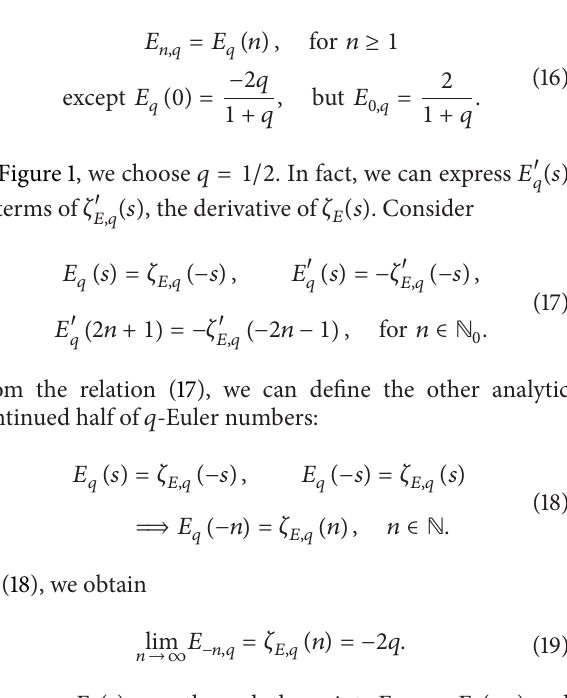
All the 𝑞 -Euler numbers 𝐸 𝑛,𝑞 agree with 𝐸 𝑞 (𝑛) , the analytic continuation of 𝑞 -Euler numbers evaluated at 𝑛 (see Figure 1). Consider